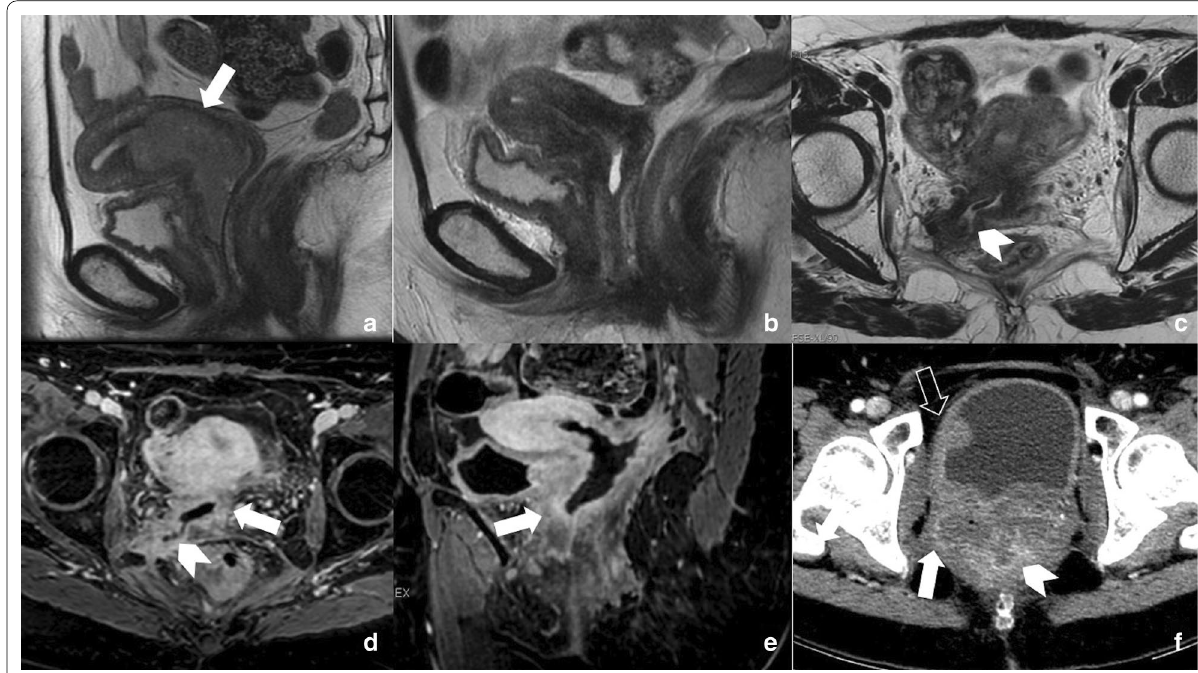
Fig. 21 A 52-year-old woman with a FIGO IIa cervical cancer (arrow in a ) treated with external beam RT and ChT, followed by high dose rate brachytherapy boost in July 2017. In December 2017 ( b ) sagittal T2-weighted image showed an almost normal reconstitution of hypointense cervical stroma. Axial T2-weighted MRI follow-up in April 2018 showed a fistulous tract (arrowhead in c ) of the right-posterior vaginal wall at the level of fornix, that blinded-ended in correspondence of piriformis muscle. Axial post-contrast fat-suppressed T1-weighted images ( d , e ) showed better the fistulous tract (arrowhead in d ) and irregular enhanced thickening of vaginal wall (arrows in d , e ), extended to cervix, which raised a strong suspicion of disease recurrence. Axial CT image performed on September 2018 showed progressive disease since the pathologic tissue infiltrated pelvic side wall, rectum and bladder (respectively arrow, arrowhead and empty arrow in f